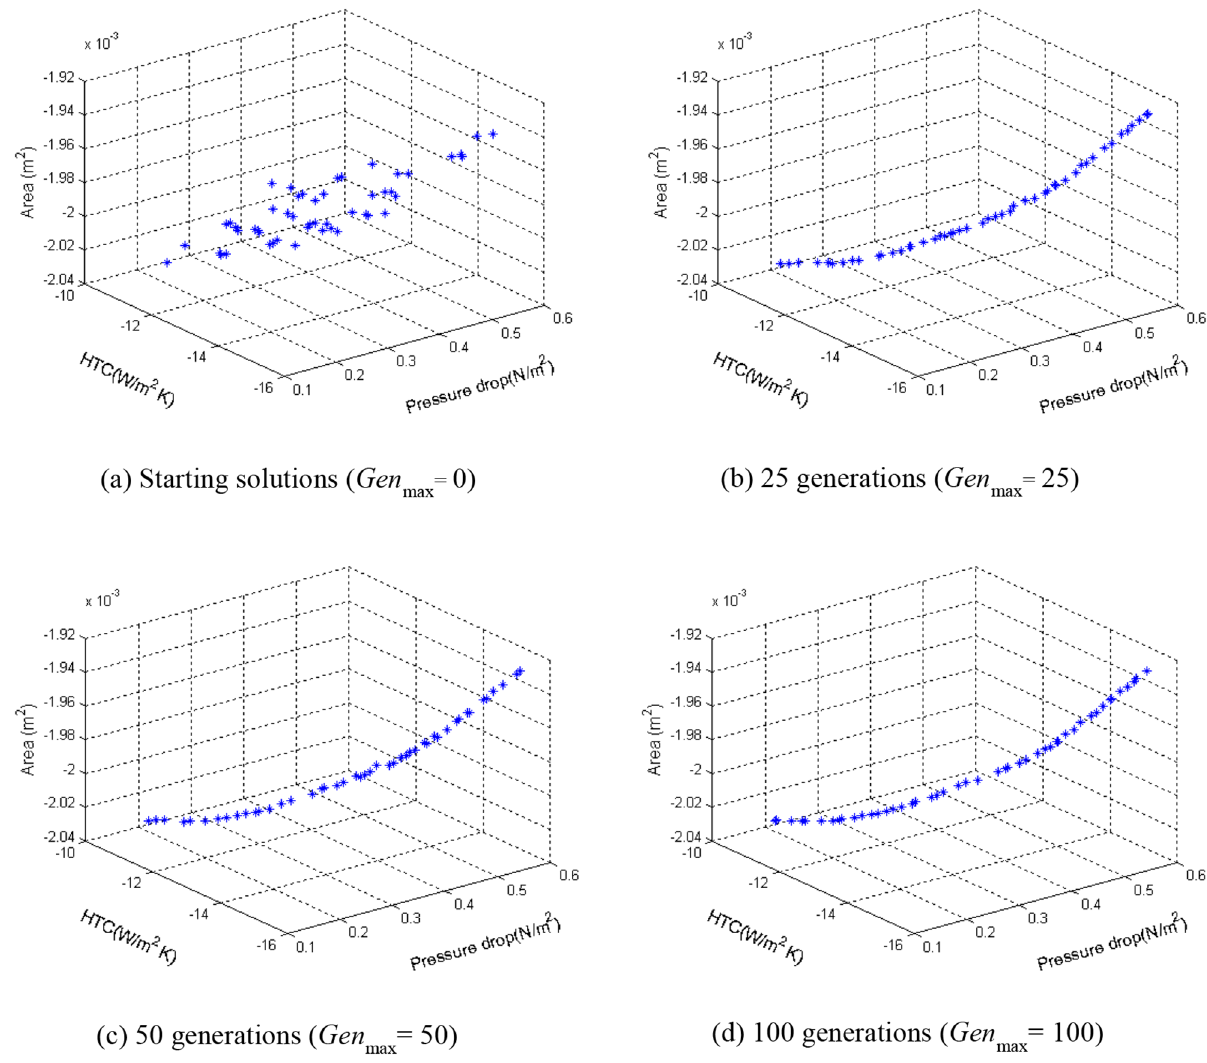
Fig. 8. Pareto optimal front of 3objectives and 2design